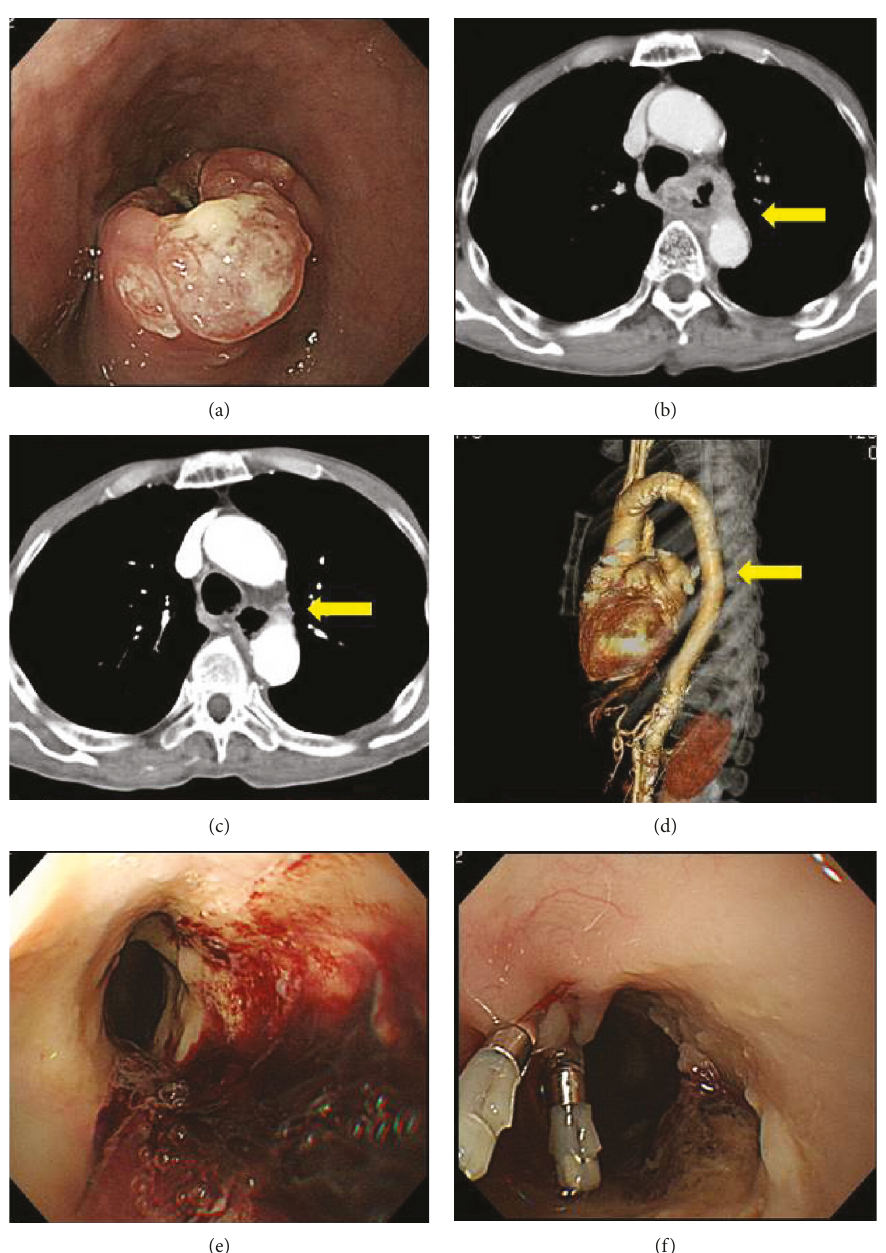
Figure 1: Imaging at the initial treatment for the aortoesophageal fi stula using the TEVAR method. (a) EGD revealed a type 2 lesion spanning 3/4 of the circumference of the middle thoracic esophagus. (b) Computed tomography scan (CT) revealed esophageal wall thickening with tumor, and there was loss of the normal fat plane between the esophagus and the adjacent aorta. Approximately 90 ° of the circumference of the aorta was in contact with the tumor, which suggested aortic invasion (yellow thin arrow). (c) CT scan revealed aortic erosion of the intravenous contrast material within the descending thoracic aorta and extraluminal foci of air between the adjacent esophagus and the aorta (yellow thin arrow). (d) CT angiography did not indicate active bleeding. (e) Emergency esophagogastroduodenoscopy showed a pale fragile esophageal lesion on the posterior wall, an area previously treated with chemoradiation therapy, with massive blood coagulation. (f) Marking clips were placed on the side opposite the